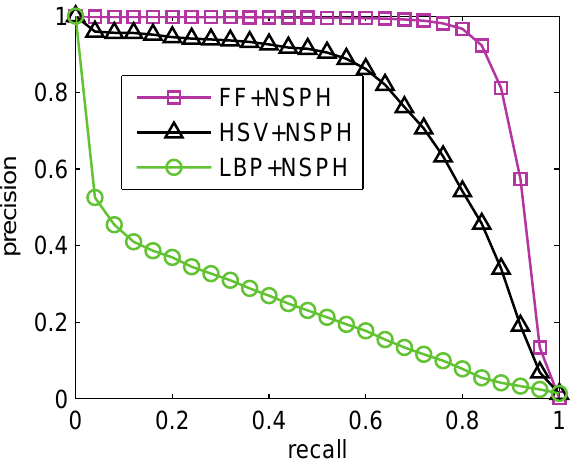
Fig. 6. Precision-Recall curve of feature fusion and single feature.